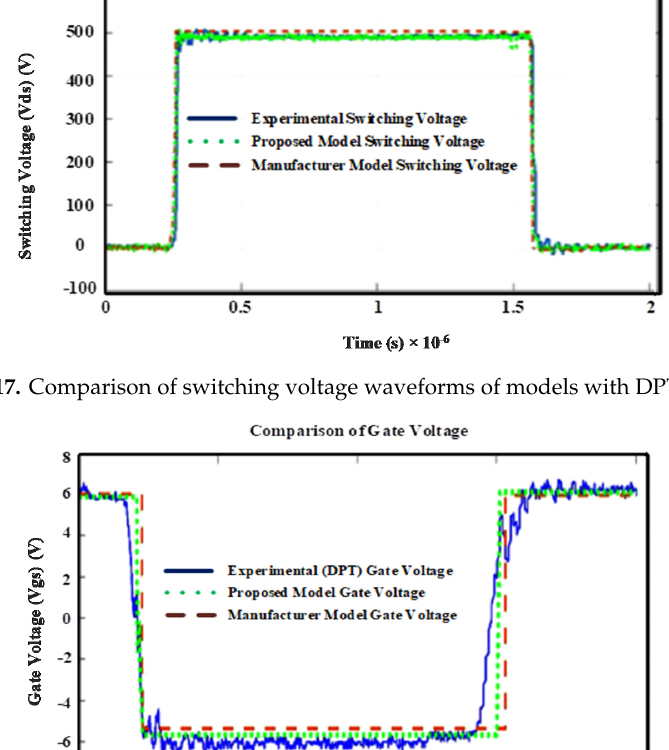
Figure 17. Comparison of switching voltage waveforms of models with DPT results.